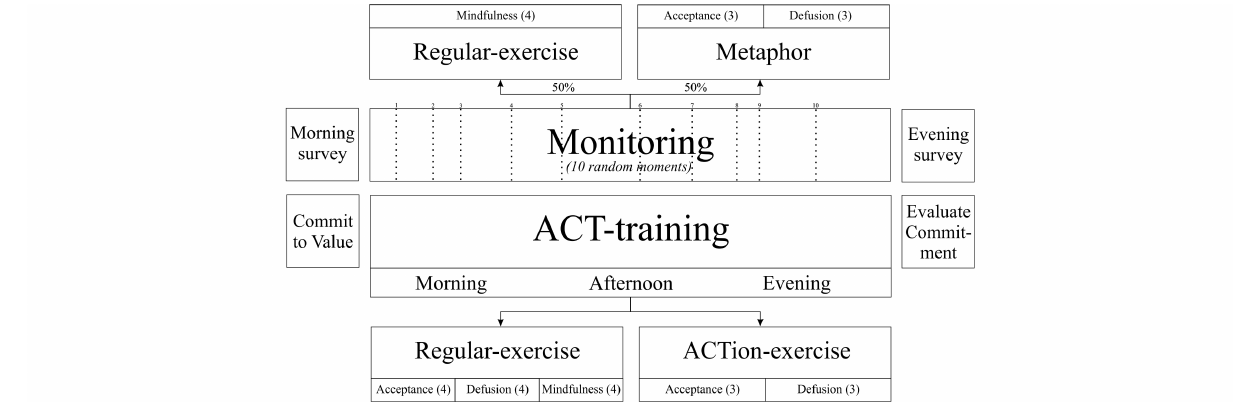
Figure 3. Schematic overview of the ACT in Daily Life Training (ACT-DL). The ACT-DL consists of two main components: monitoring and ACT